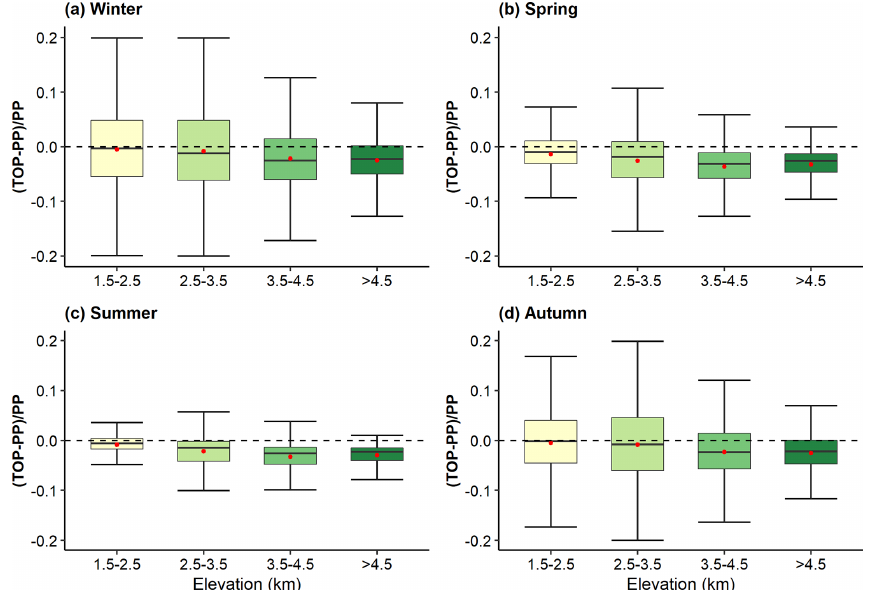
Figure 6. Boxplots of the relative differences in land surface albedo between TOP and PP for all seasons at four different elevation bands. Red points represent the mean